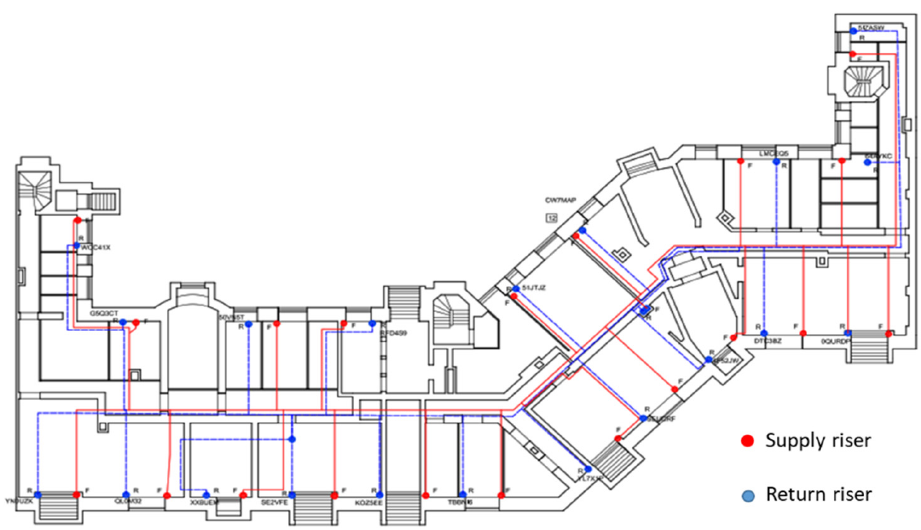
Figure 3. Building A plan and schematic view of the pipelines and risers; temperature sensors are installed on each return riser.